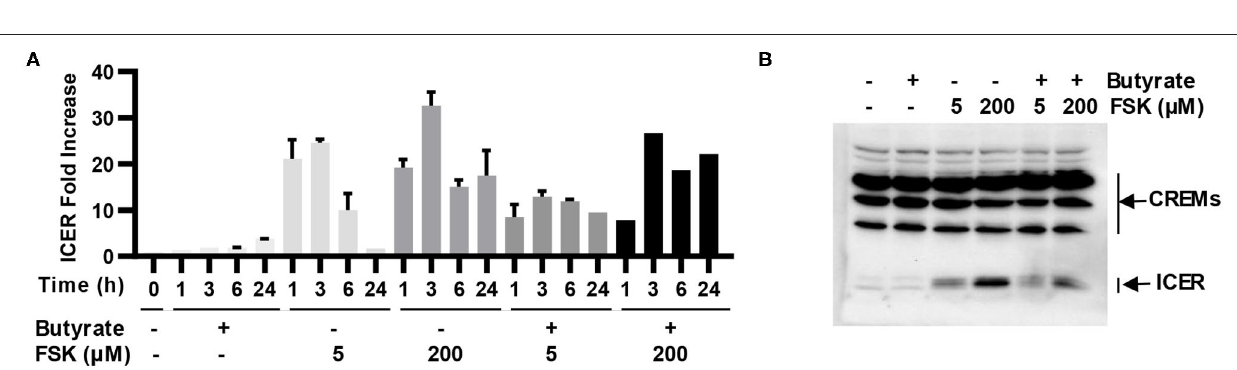
FIGURE 6 | Kinome profiling of chicken macrophages in response to butyrate and FSK. Chicken HD11 cells were treated in duplicate with or without 2mM butyrate, 5 µ M FSK, or in combination for 4h, followed by cell lysis and kinome peptide array analysis for differential phosphorylation status of kinases and phosphatases. (A) Venn diagram showing the number of differentially phosphorylated peptides overlapping among the three treatments. (B) Heatmap showing the profiles of differentially phosphorylated peptides in response to different treatments. Differentially regulated peptides were selected with P < 0.001 (relative to the control). Each horizontal line represents a peptide and its phosphorylation status, with red indicating phosphorylation and green indicating dephosphorylation.